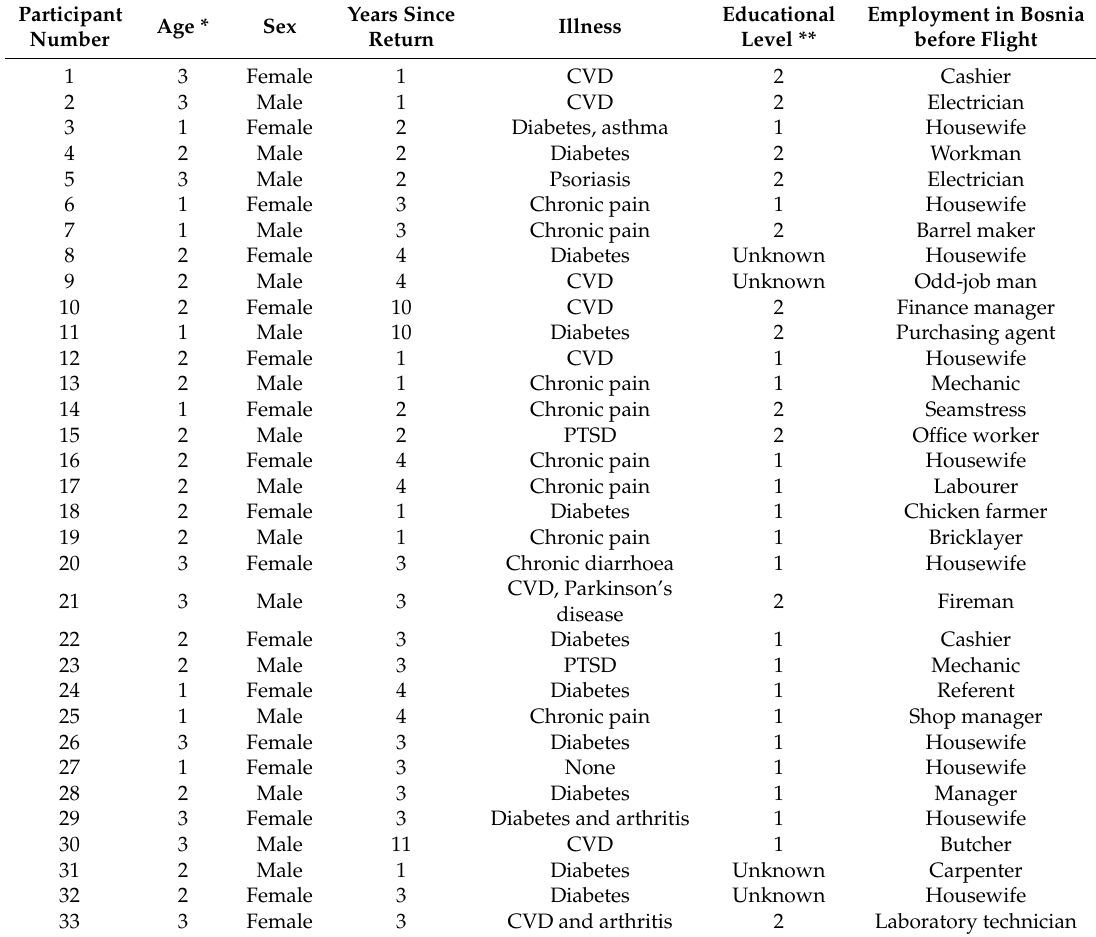
Table 1. Characteristics of